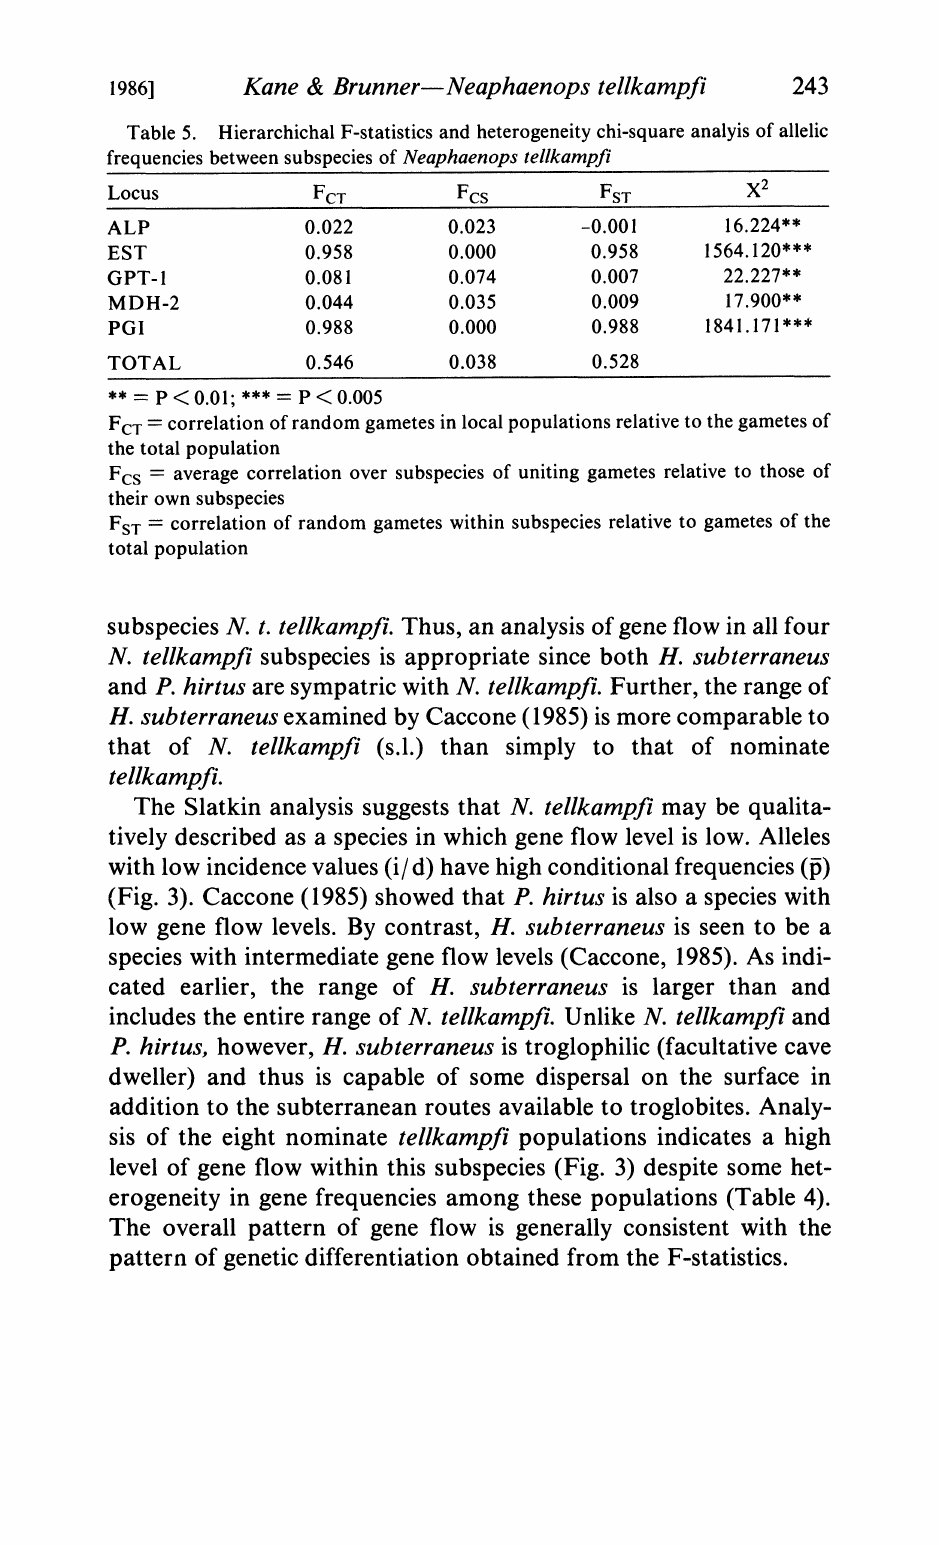
Table 5. Hierarchiehal F-statistics and heterogeneity chi-square analyis of allelic frequencies between subspecies of Neaphaenops